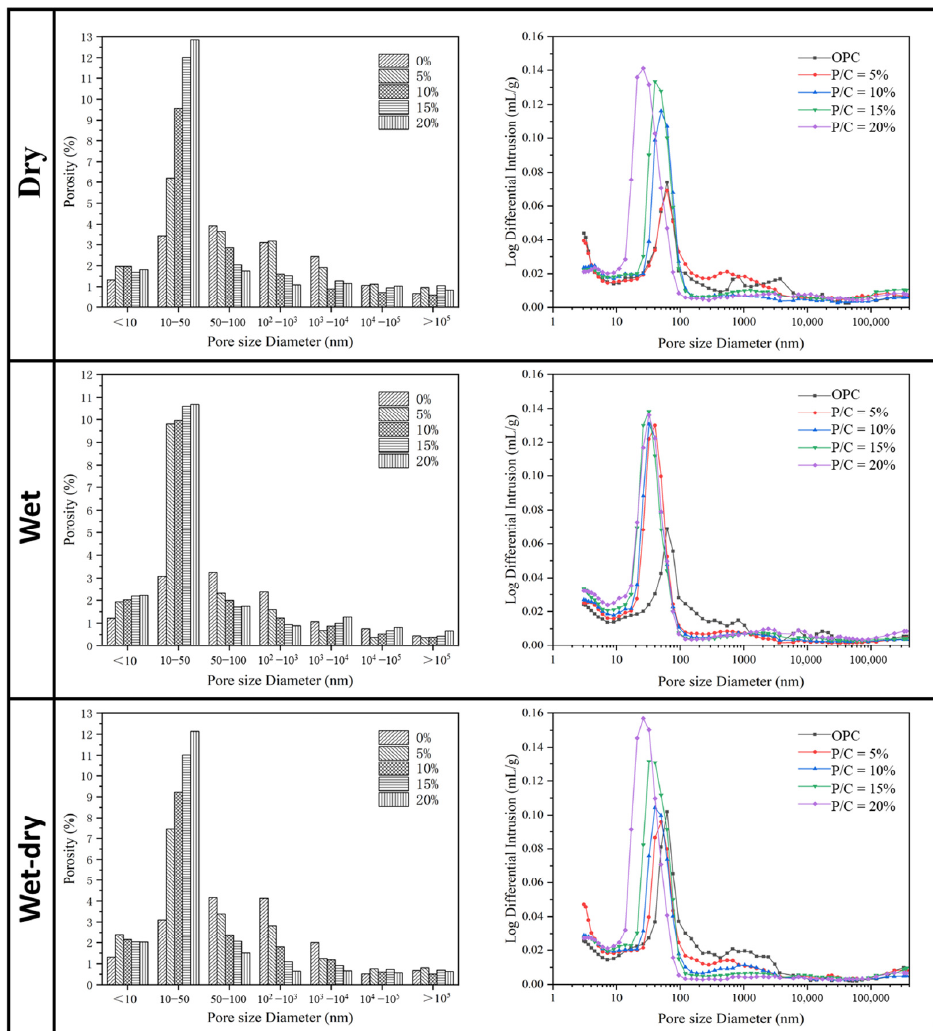
Figure 9. The pore structure of epoxy latexes modified mortars at 90 d under three curing